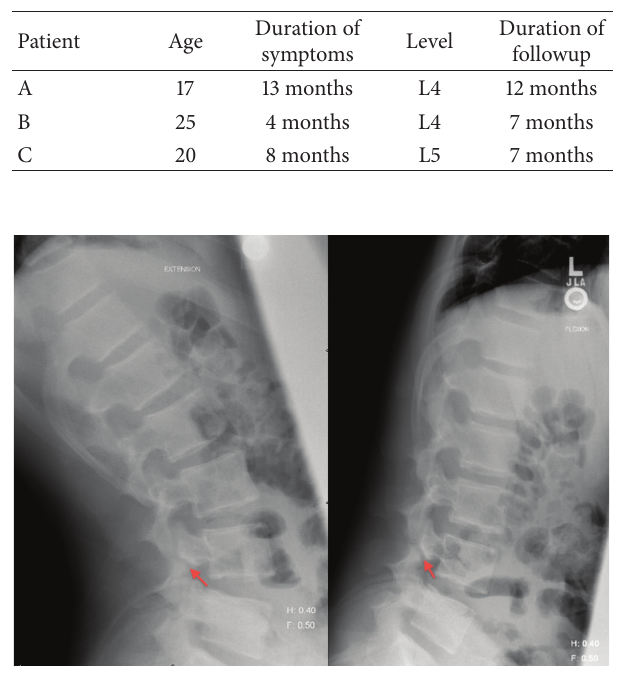
Figure 1: Flexion/extension preoperative rays of patient A showing increased separation of the pars defect with flexion.